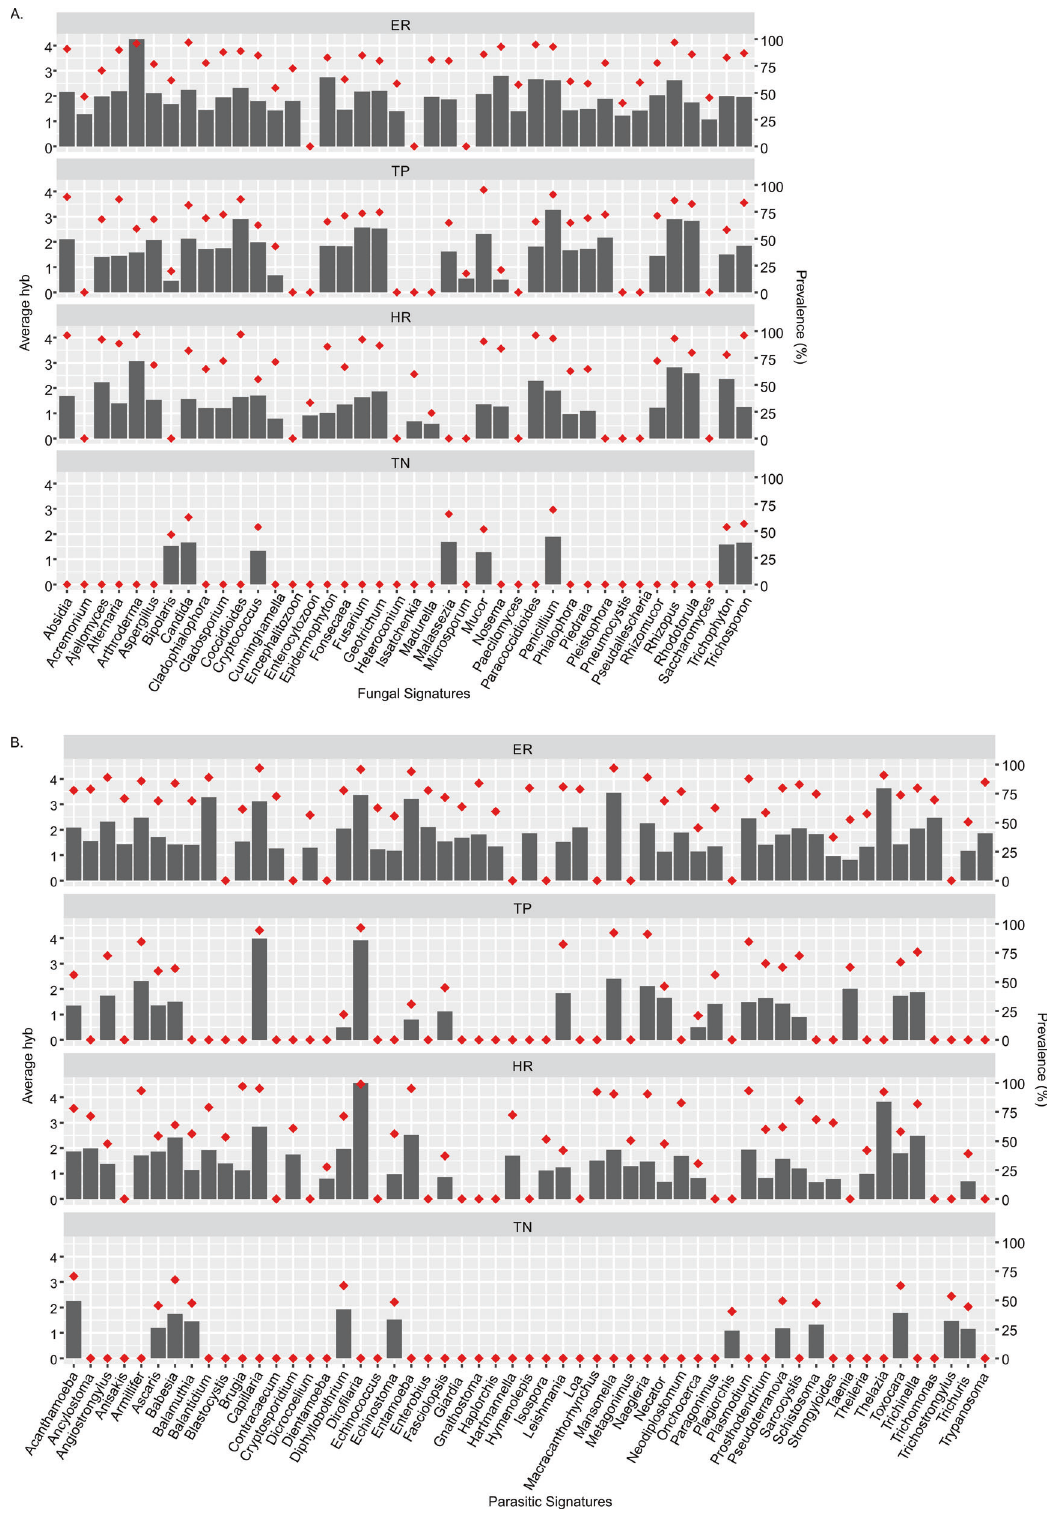
Fig. 3 Fungal and parasitic signatures detected in the breast cancers. A , B The bars represent the average hybridization signal for each fungal or parasitic signatures, while the percent prevalence of those fungal or parasitic signatures in the sample set is indicated by the orange